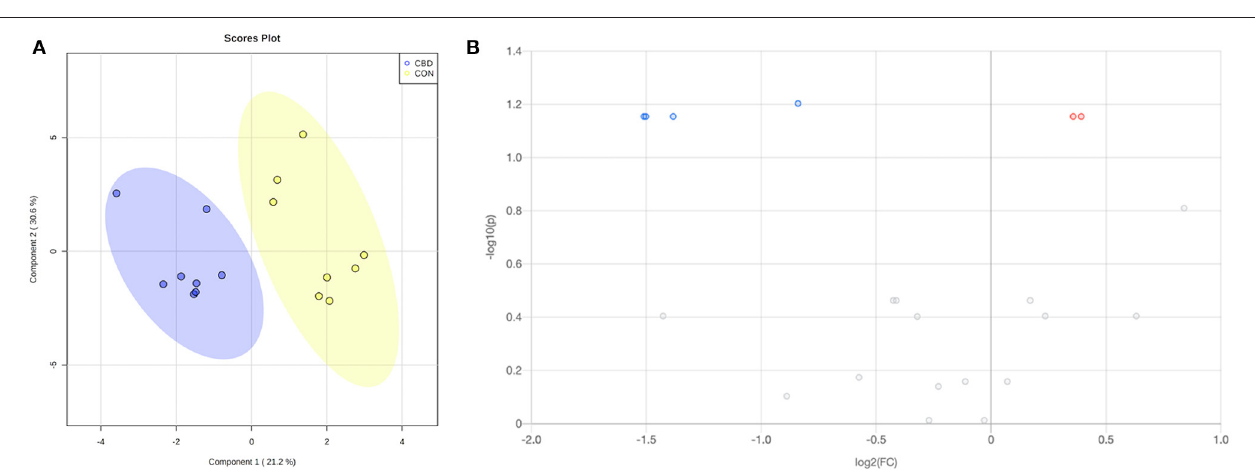
FIGURE 3 | (A) Partial least squares discriminant analysis (PLS-DA) scores plot and (B) volcano plot showing the differential carbonyl-containing metabolites. Fold change (FC) ≥ 1.2 (in red) or ≤ 0.83 (in blue) with false discovery ratio (FDR) ≤ 0.05 are differentially increased or reduced by cannabidiol (CBD) relative to control (CON).